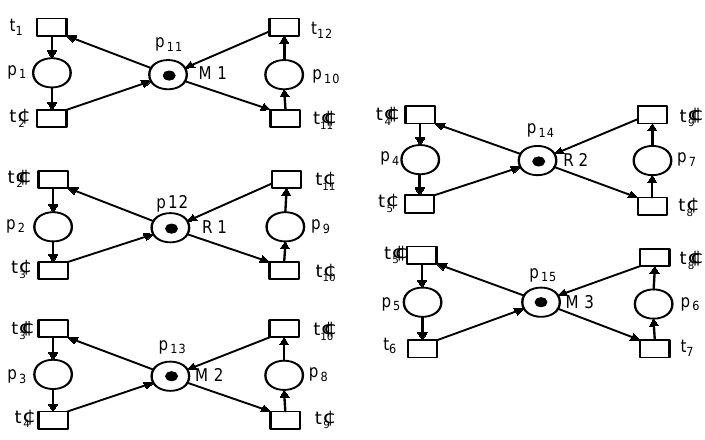
Figure 3. Decentralized working zones.